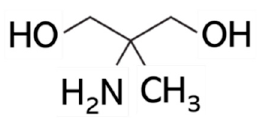
Figure 1. Chemical structure of 2-amino-2-methyl-1,3-propanediol (AMPD).